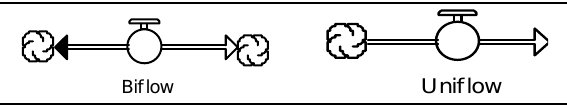
Figure 4. Types of